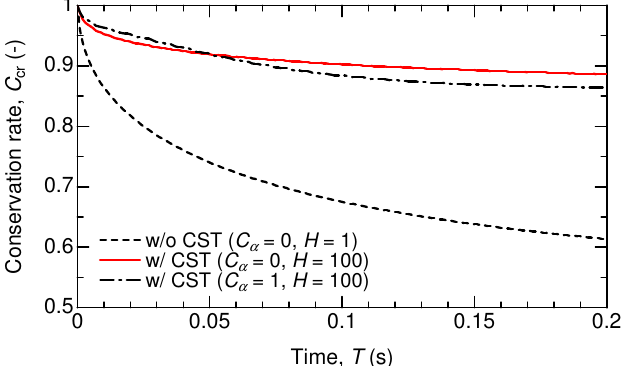
Figure A3. Comparison of the temporal variation of conservation of C cis in the